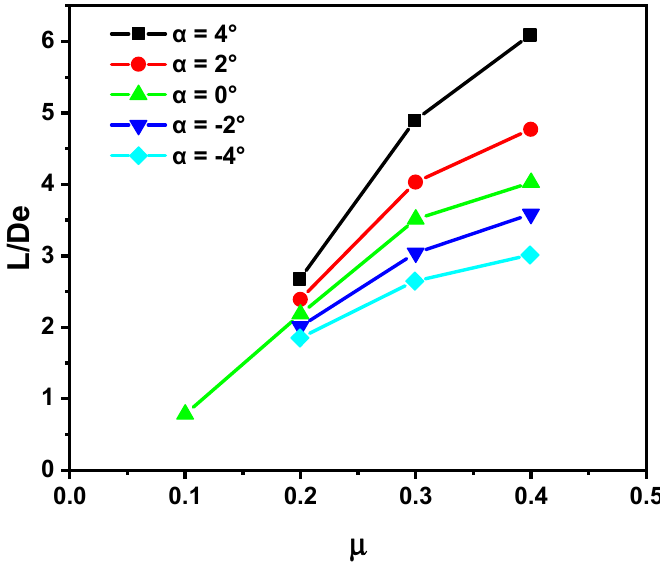
Figure 8. Effective lift-to-drag (L/De) ratio as a function of the advance ratio ( μ ), 1860 rpm.